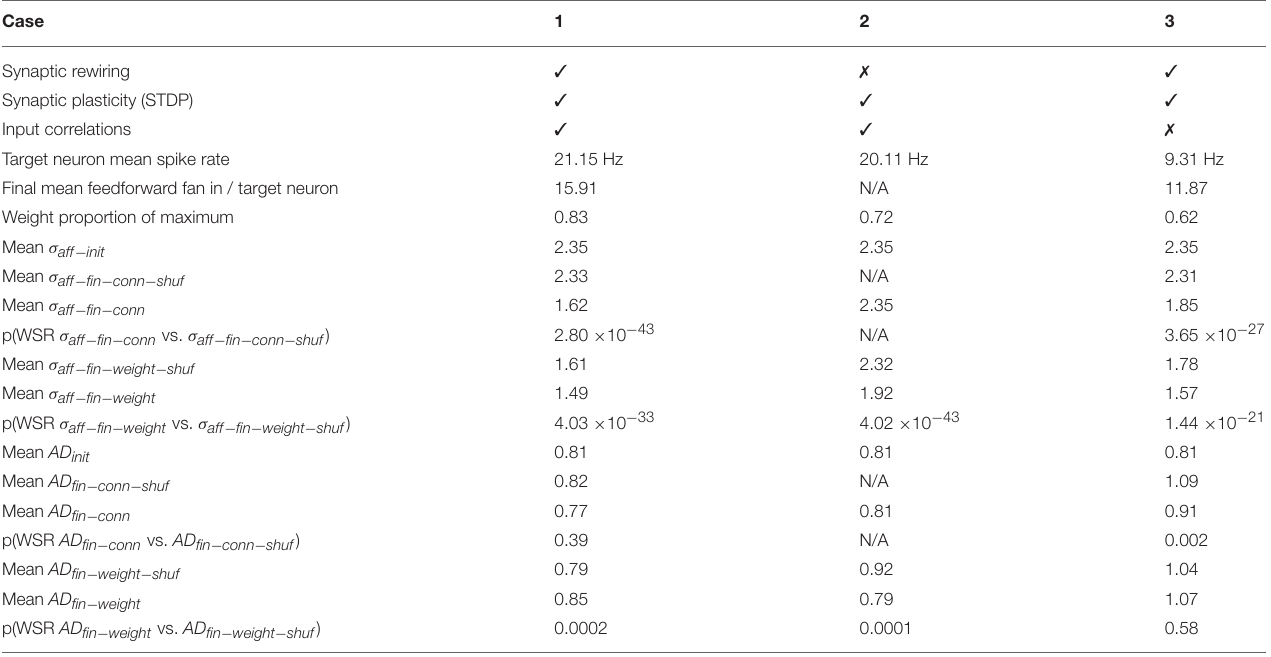
TABLE 2 | Simulation results presented in a similar fashion to Bamford et al. (2010) for three cases, all of which incorporate synaptic